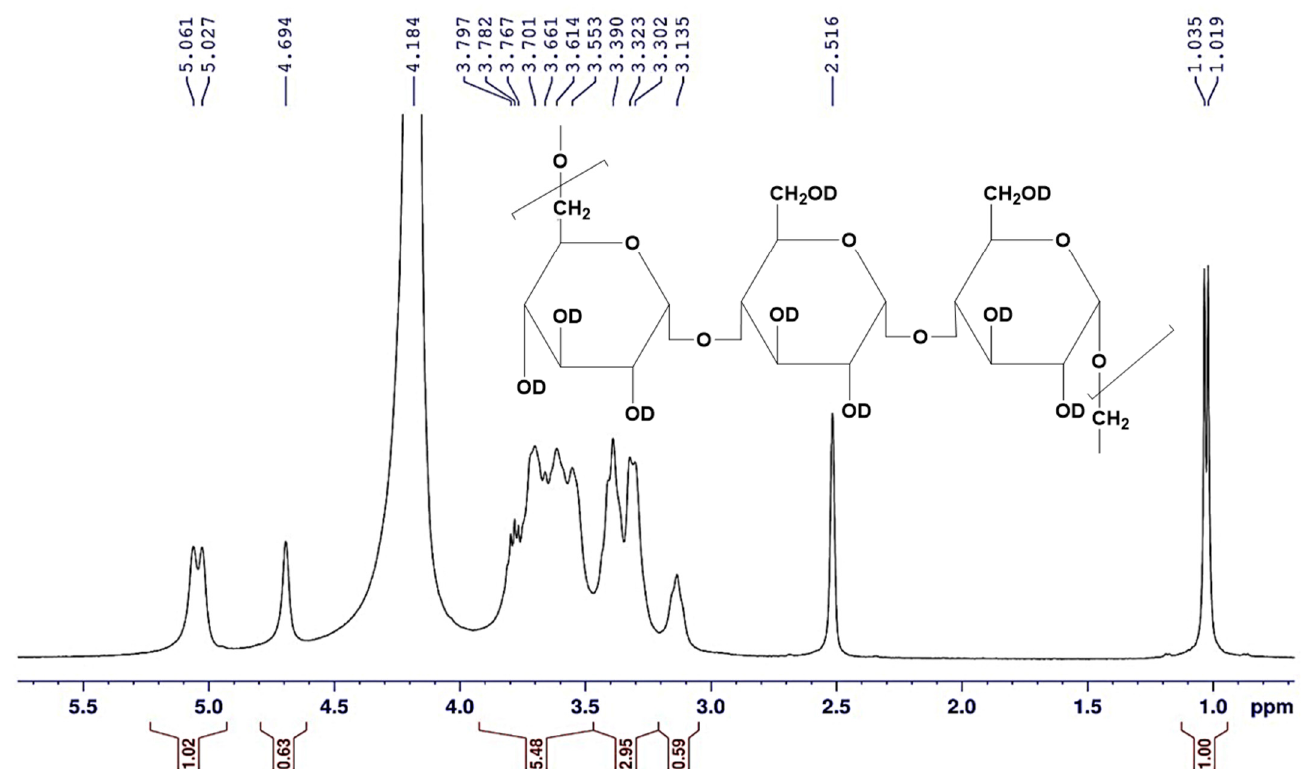
Figure 10. The magnification of the aliphatic region in the 1 H-NMR (DMSO- d 6/D 2 O) spectrum of the A. pullulans AKW pullulan.